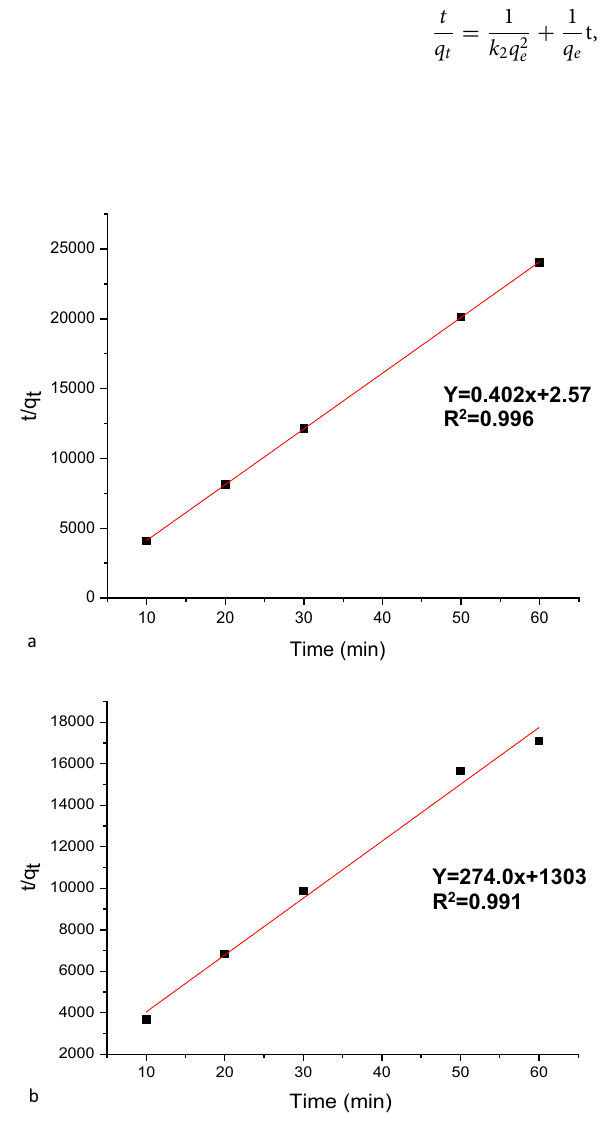
Figure 15. Pseudo-second order for the adsorption of MG onto ( a ) nano bentonite and ( b ) MgO impregnated